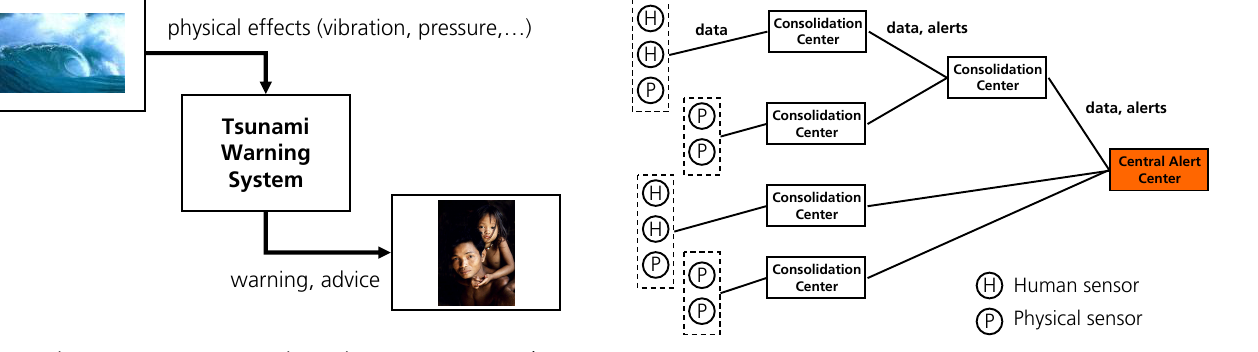
Fig. 2. Convergent section of a warning system. Information from both human and physical sensors is forwarded towards a central warning center.